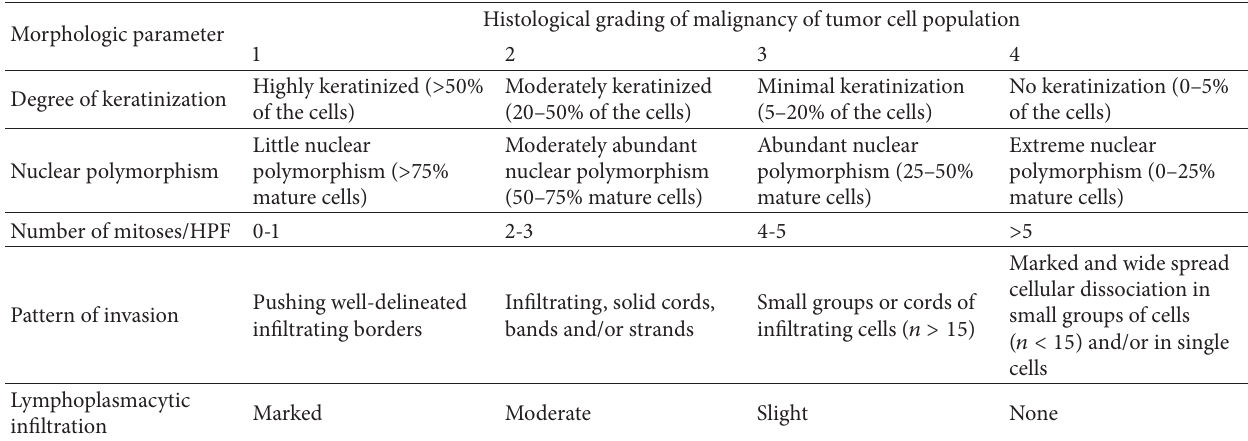
Table 1: This table depicts the new malignancy grading system of oral squamous cell carcinoma patients as proposed by Anneroth et al. (1986) [6] and Bryne et al. (1989 and 1991) [7,